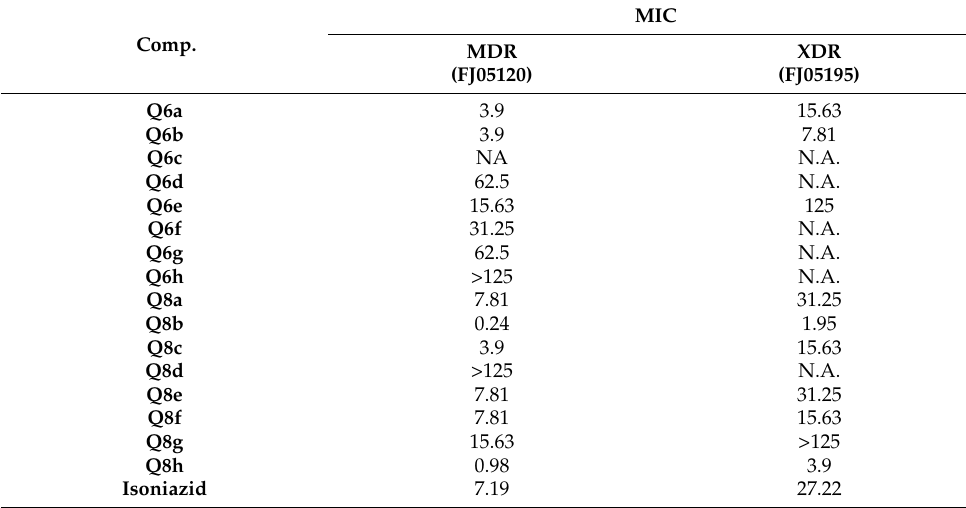
Table 2. Anti-tubercular activities for the target quinolines ( Q6a – h ) and ( Q8a – h ) against MDR and XDR M. tuberculosis